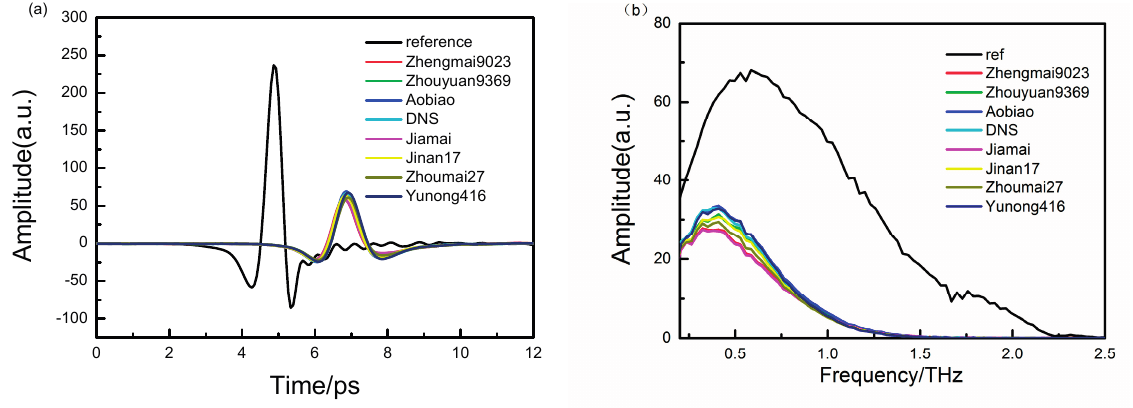
Figure 1. ( a ) Time-domain THz spectra of the eight wheat samples and reference; and ( b ) the frequency spectra of the eight wheat samples and the reference in the range of 0.2–2.5 THz.